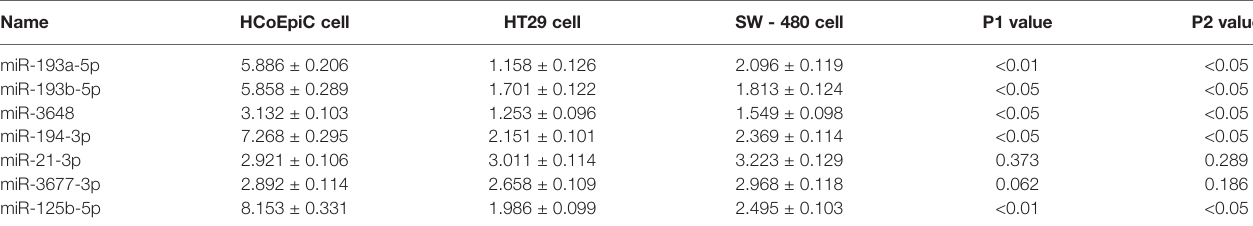
TABLE 3 | Relative expression of seven miRNAs from the prognostic model in normal colon cells (HCoEpiC), colon cancer cells (HT29, SW-480).